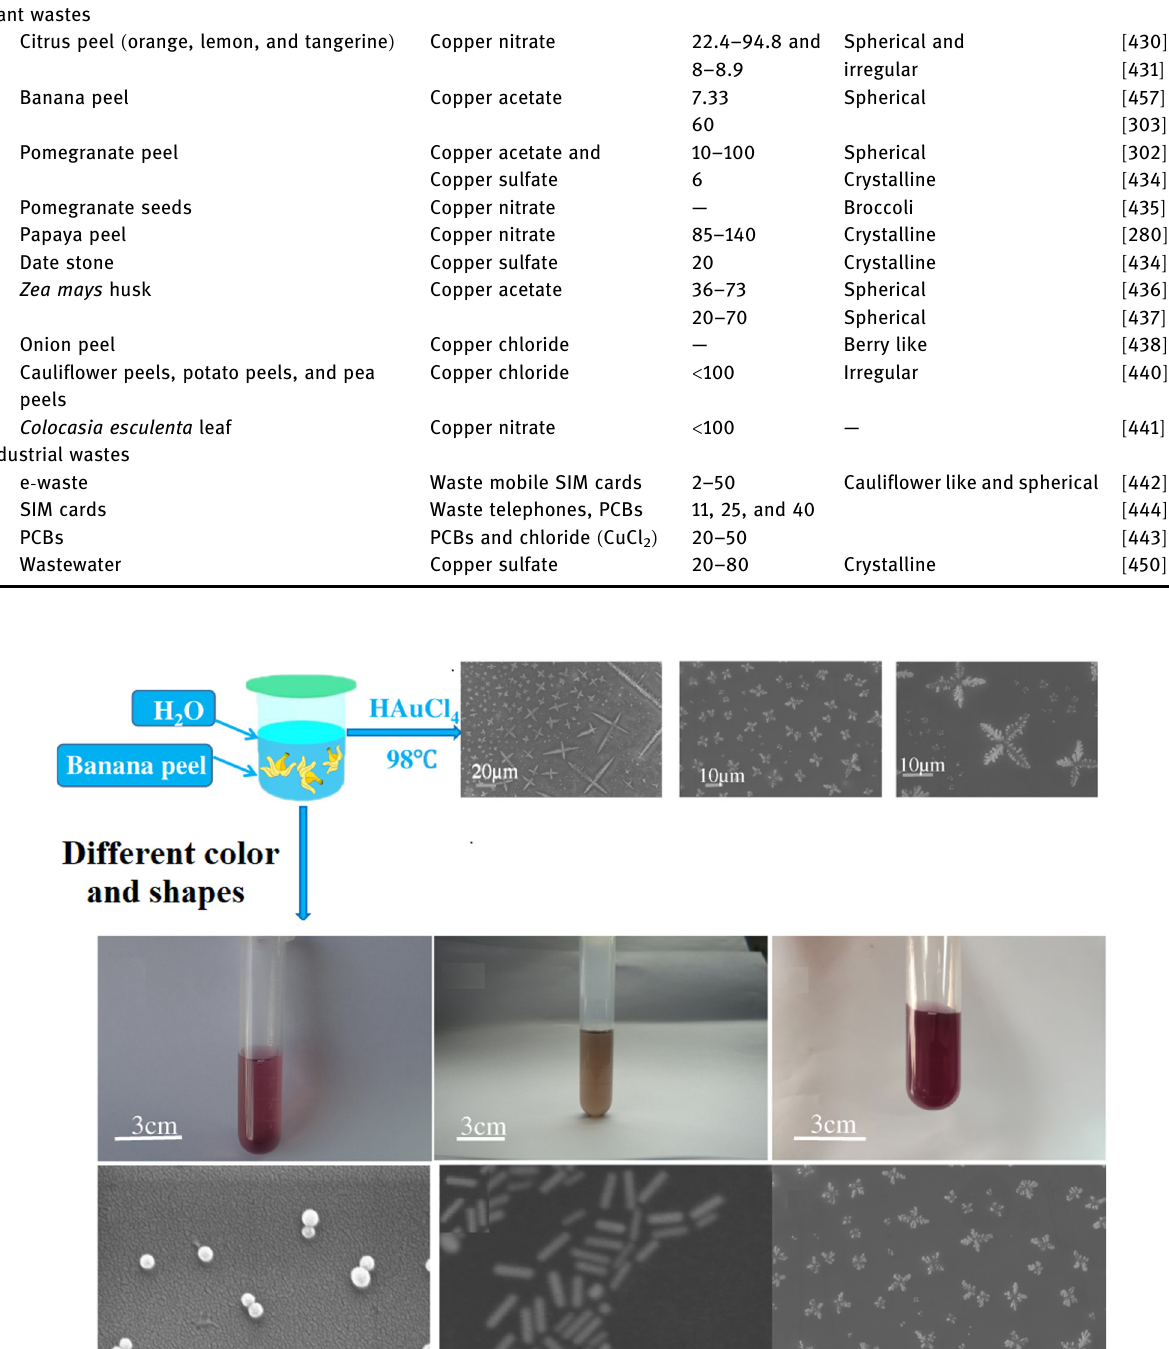
Table 11: : Various waste materials for CuO NP synthesis and their corresponding properties Waste material